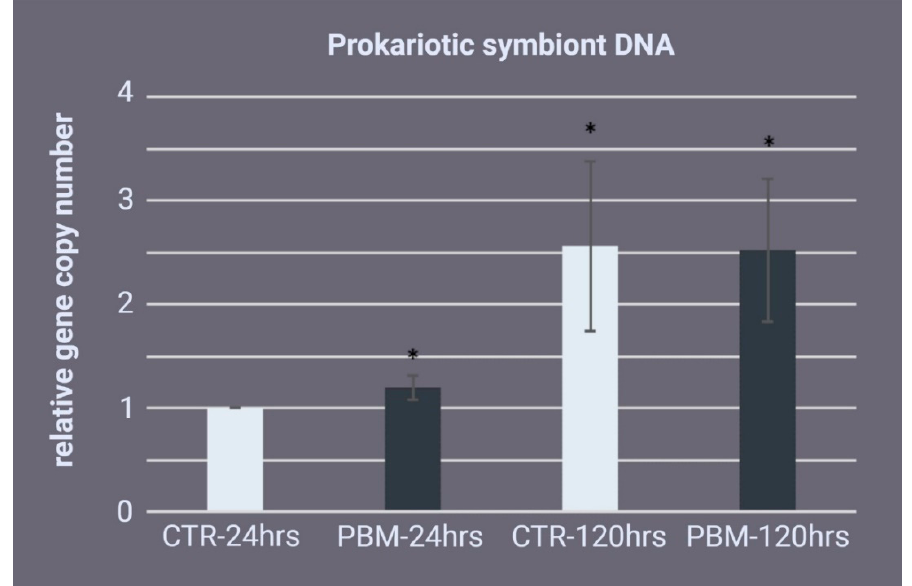
Figure 6. Prokaryotic symbiont DNA quantification. Analysis of the sponge prokaryotic symbiont population based on real-time PCR DNA quantification in the regenerating Chondrosia reniformis specimens 24 h postinjury and the first dose of 810 nm-1 W photo-biomodulation (PBM-24 h) and 120 h postinjury (PBM-120 h). The control groups (CTR-24 h and CTR-120 h) are the respective non-irradiated samples. The data are expressed as the prokaryotic DNA gene copy number relative to CTR-24 h and are normalised to the GAPDH gene copy number. Each bar represents the mean ± standard deviation of the three independent experiments performed in triplicate. The data were analysed with a one-way analysis of variance (ANOVA) followed by Tukey’s test (ANOVA p = 0.006047). The asterisks indicate a significant difference between groups based on Tukey’s test (versus CTR-24 h, * p < 0.05).